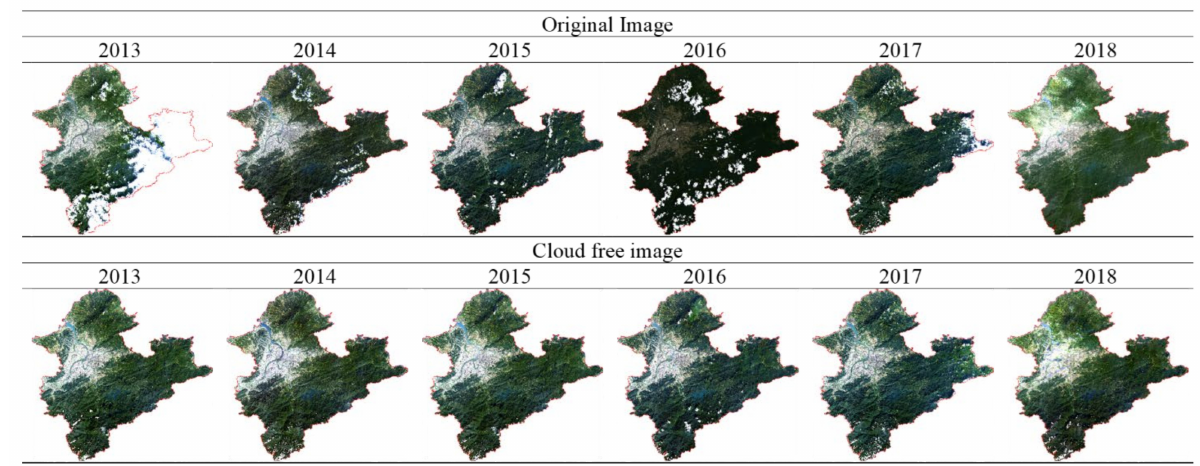
Figure 5. Original ( top ) and cloud-free satellite images ( bottom ) from 2014 to 2018.